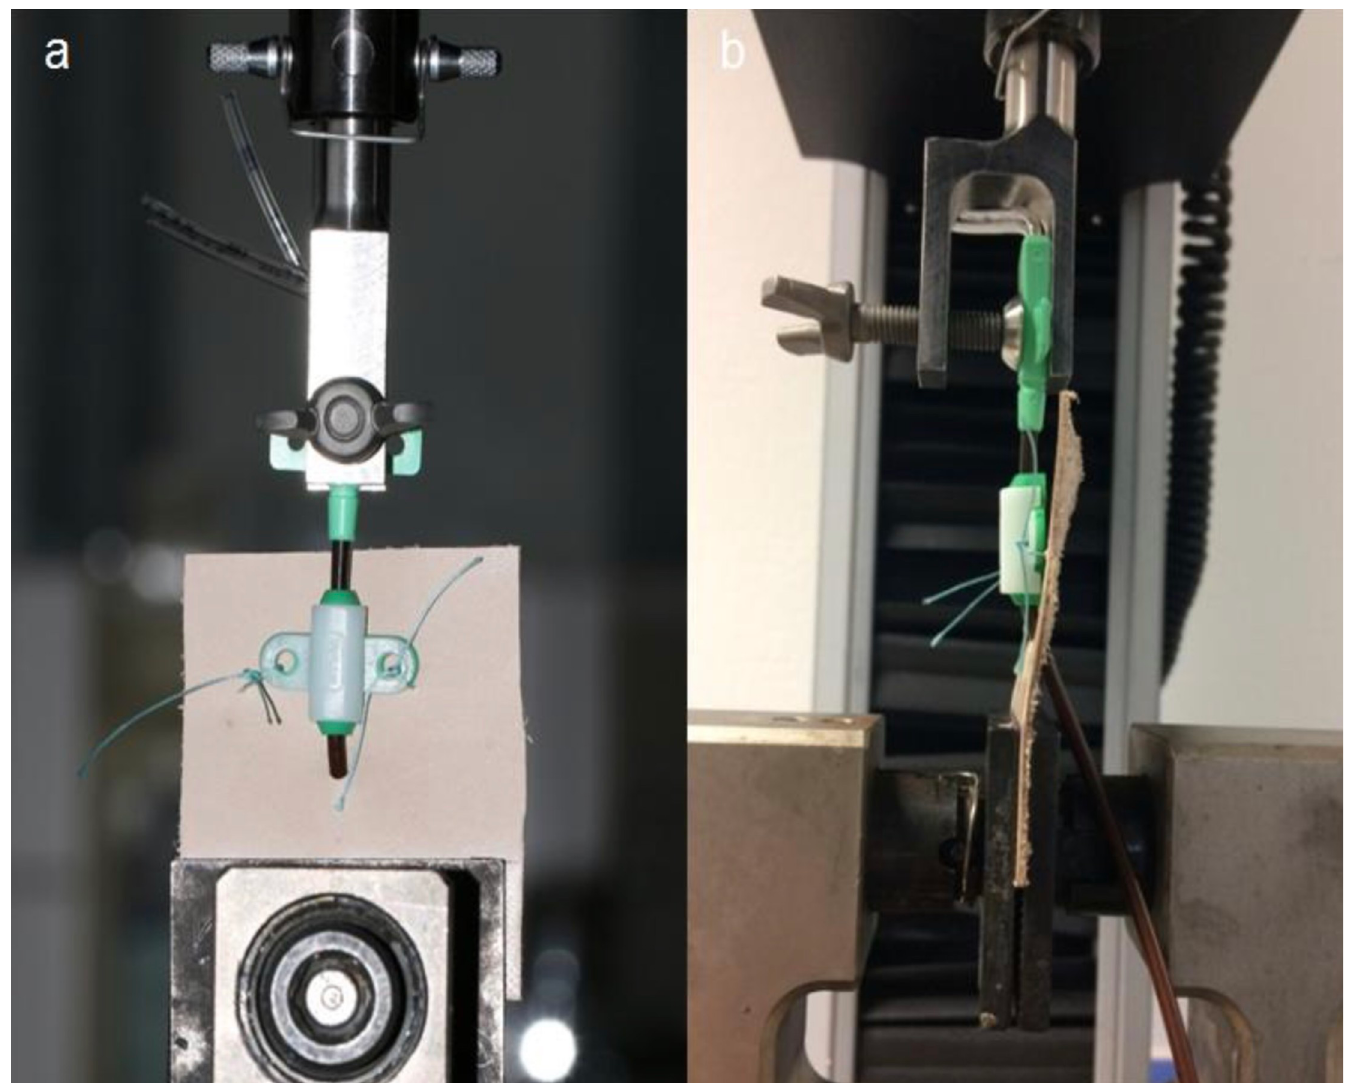
Fig 3. Test setting. Anterior view (a) and lateral view (b) of the sutured central venous catheter unit mounted on the tensile testing